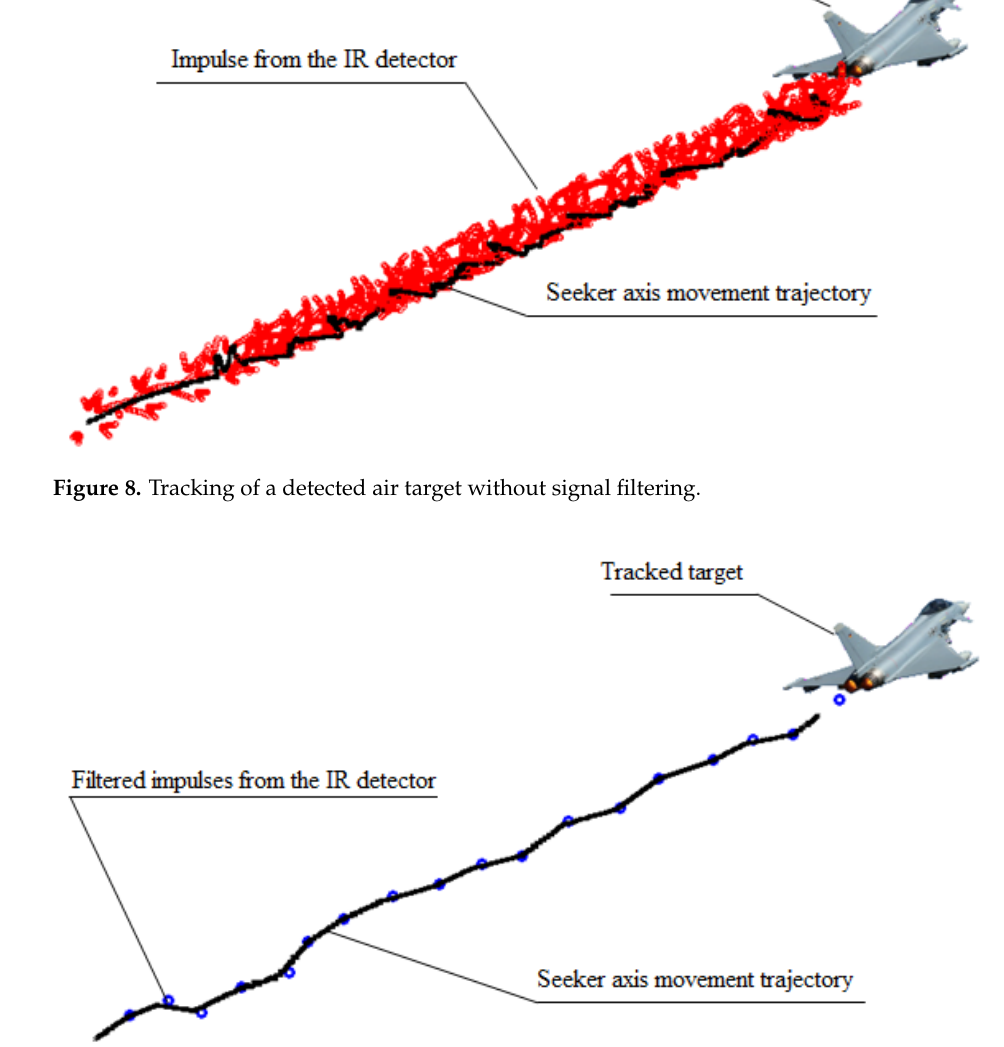
Figure 9. Tracking a detected air target using signal filtering.